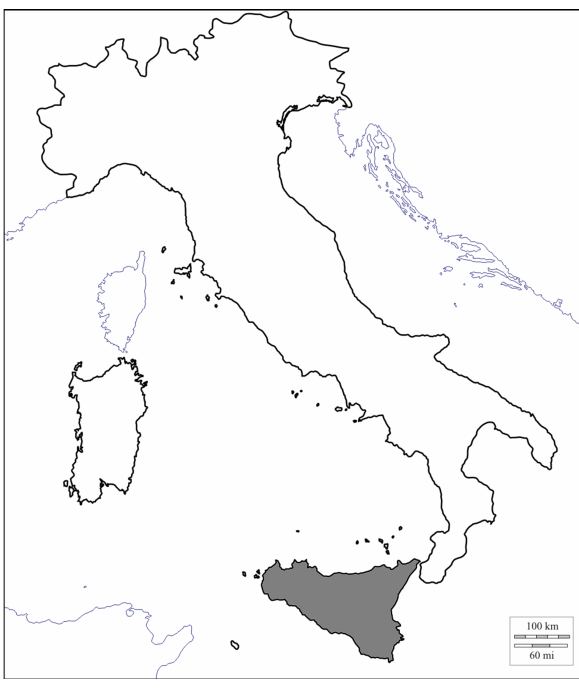
Figure 2. Distribution map of Microtus nebrodensis (redrawn from Bezerra et al. 2016).